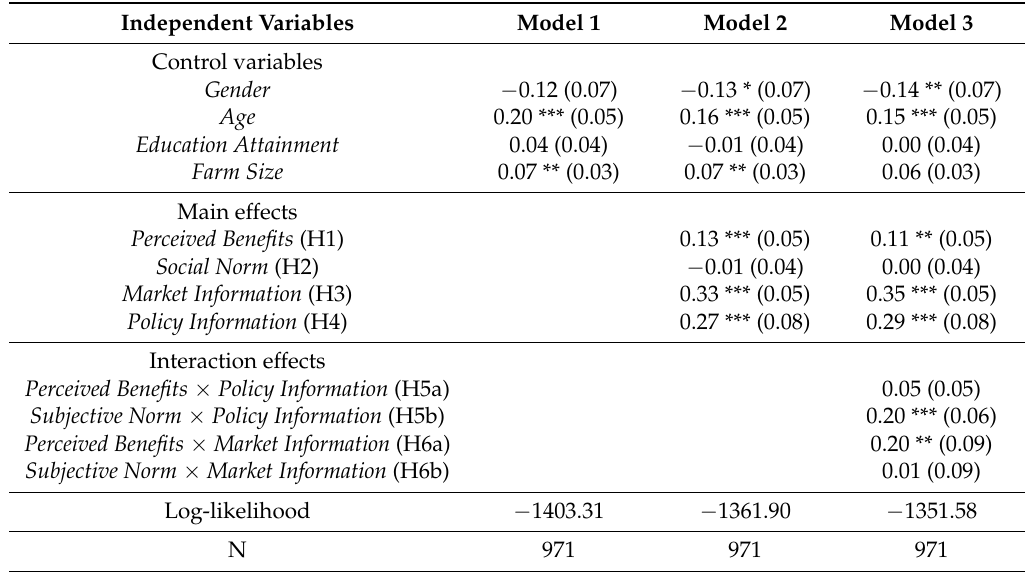
Table 5. Results of the step-wise Ordered Probit